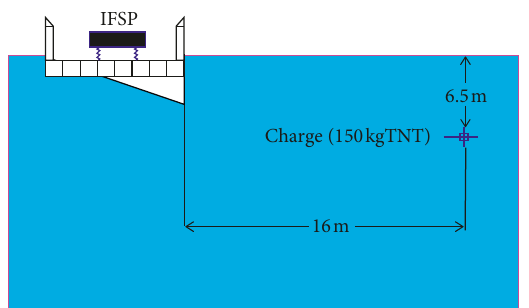
Figure 14: Calculation diagram of the underwater explosion